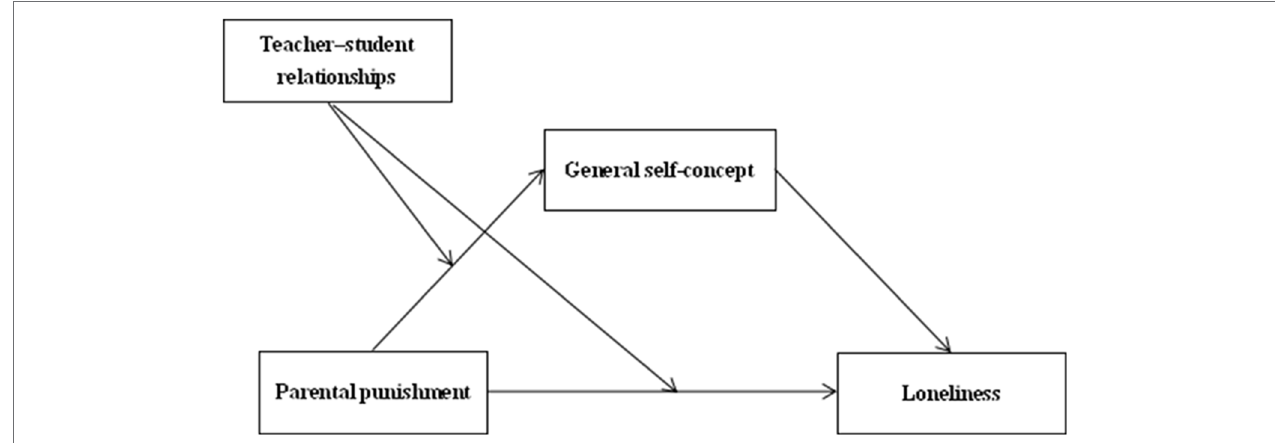
FIGURE 1 | Hypothetical